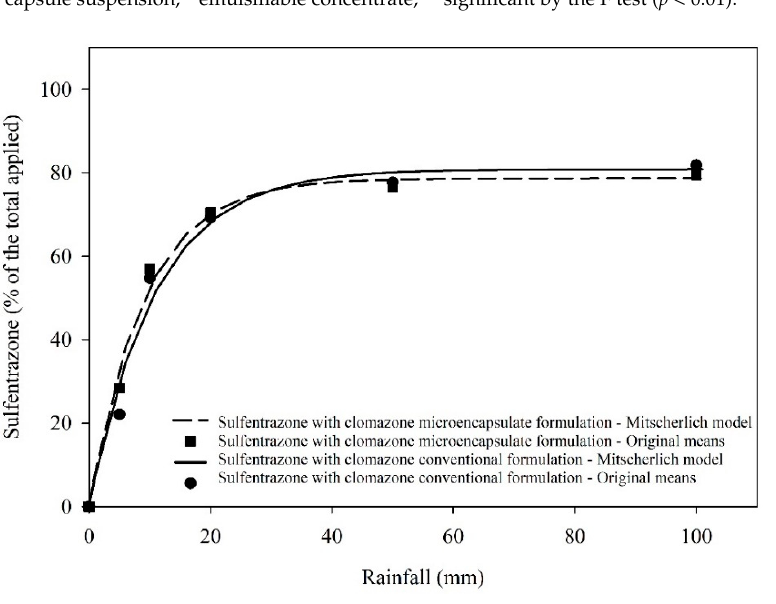
Figure 4. Quantity of sulfentrazone herbicide (% of the total applied) percolated through sugarcane straw as a function of different simulated rainfall depths (mm), after application combined with emulsifiable concentrate formulation (EC) or microencapsulated formulation (CS) of clomazone. The sulfentrazone with the rainfall water percolated easily through the sugarcane straw, and the quantities presented no significant differences when it was applied combined with the clomazone formulations (EC and CS). Matos [41] evaluated combinations of the herbicides sulfentrazone and diuron and found that the percolation of sulfentrazone was